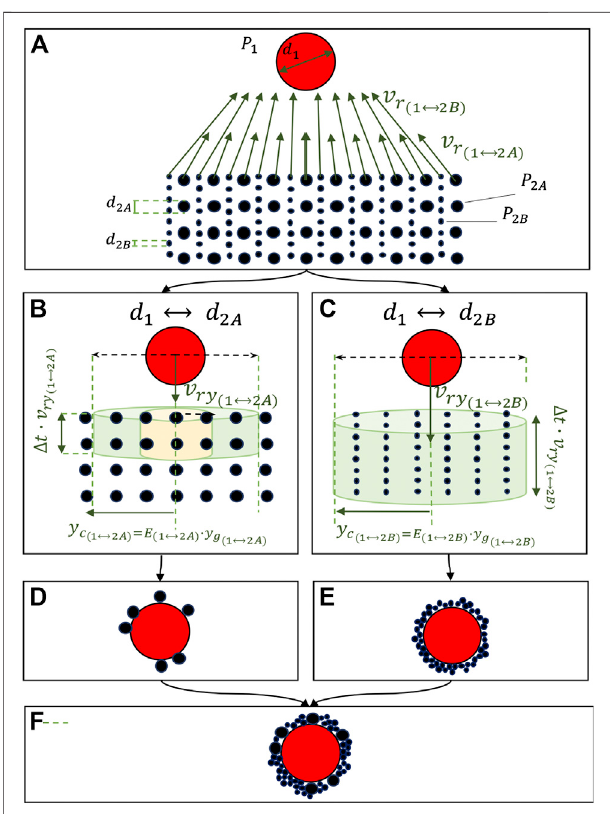
FIGURE 5 | Schematic representation of oppositely charged particles formingacoredcluster. Thered particleispositively charged attheionization limit, the black particles are negatively charged at the ionization limit. (A) core particle falling through a cloud of smaller particles, characterised by a bimodal grainsize distribution. Velocity vectors are shown in the reference system of the larger particle. (B) swept volume (in green) relative to the interactions between P 1 and P 2A (sticking volume is represented in orange), (C) swept volume (in green) relative to the interactions between P 1 and P 2B . In both Figures (B) and (C) , the velocities are drawn with respect to the reference system of P2. (D) and (E) show the particles that stick with the core. (F) fi nal cored cluster (i.e. initial core particle surrounded by a variety of particles P2A and